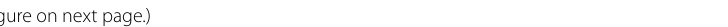
figure on next Fig. 3 Knockdown of HSP72 retards the effect of baicalin on the treatment of COPD. Cells were treated with CSE, CSE baicalin, + CSE baicalin si-NC, or CSE baicalin si-HSP72. Mice were treated with CS LPS, CS LPS baicalin, or CS LPS baicalin CCT251236. a + + + + + + + + + + The expression of HSP72 normalized to GAPDH was detected by immunoblotting in cells; * p < 0.05, ** p < 0.01, *** p < 0.001 compared to untreated cells; # p < 0.05, ## p < 0.01, ### p < 0.001 compared to cells treated with CSE baicalin si-NC. b The viability of the above cells was determined by + + CCK-8; * p < 0.05, ** p < 0.01, *** p < 0.001 compared to untreated cells; # p < 0.05, ## p < 0.01, ### p < 0.001 compared to cells treated with CSE; & p < 0.05, && p < 0.01, &&& p < 0.001 compared to cells treated with CSE baicalin si-NC. c Flow cytometry was used to analyze apoptosis of the cells. d Release + + of inflammatory factors IL-6, IL-8 and TNF-α was measured by